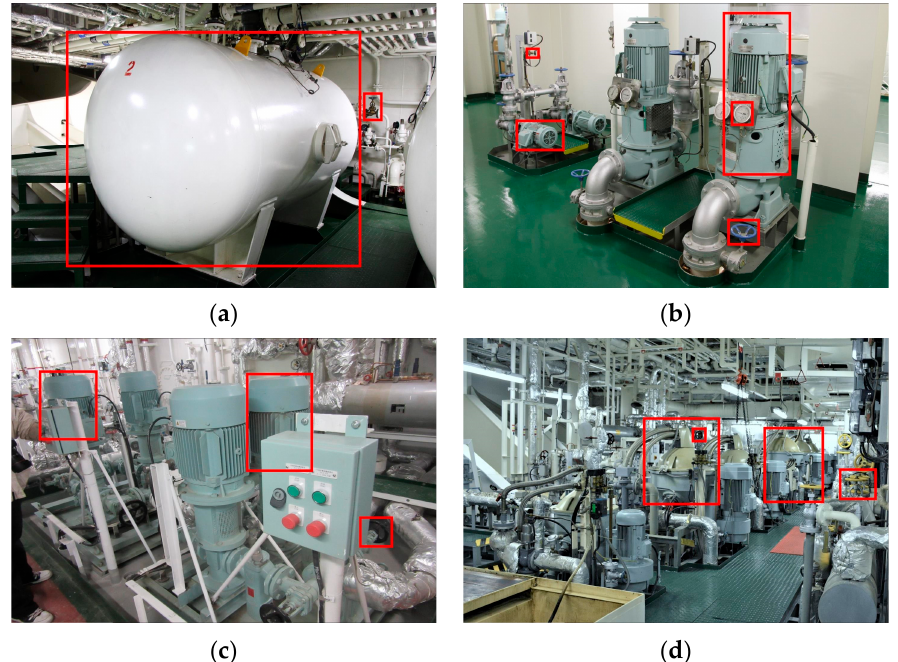
Figure 1. The difficulties of visual recognition in a marine engine room. In ( a ), the reservoir takes up more than 55% of the image while the valve accounts for less than 1%. In ( b ), the scale differences between the same equipment are general. In ( c ), the pumps and the valve are occluded by the former equipment. In ( d ), the overlaps between the equipment will cause an impact on the training